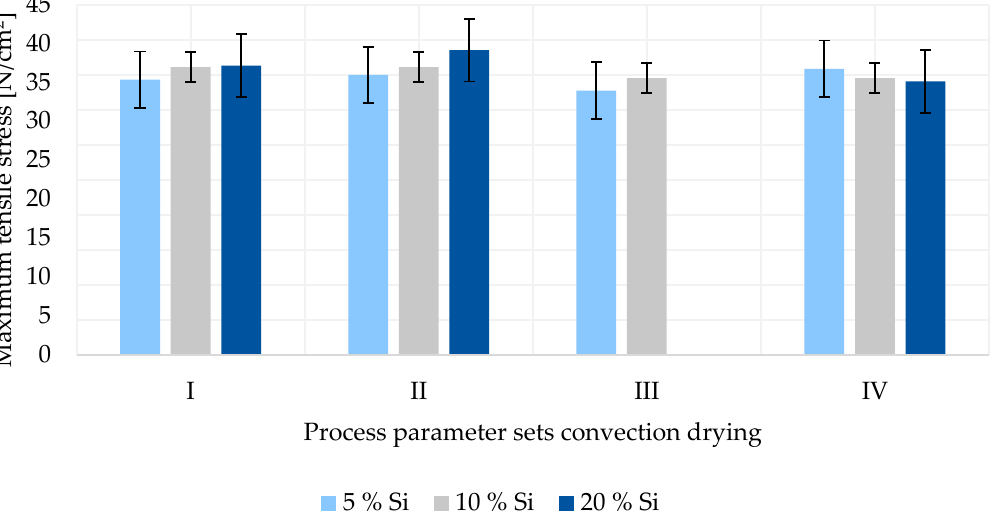
Figure 4. Adhesion force of silicon–graphite anodes dried by convection.